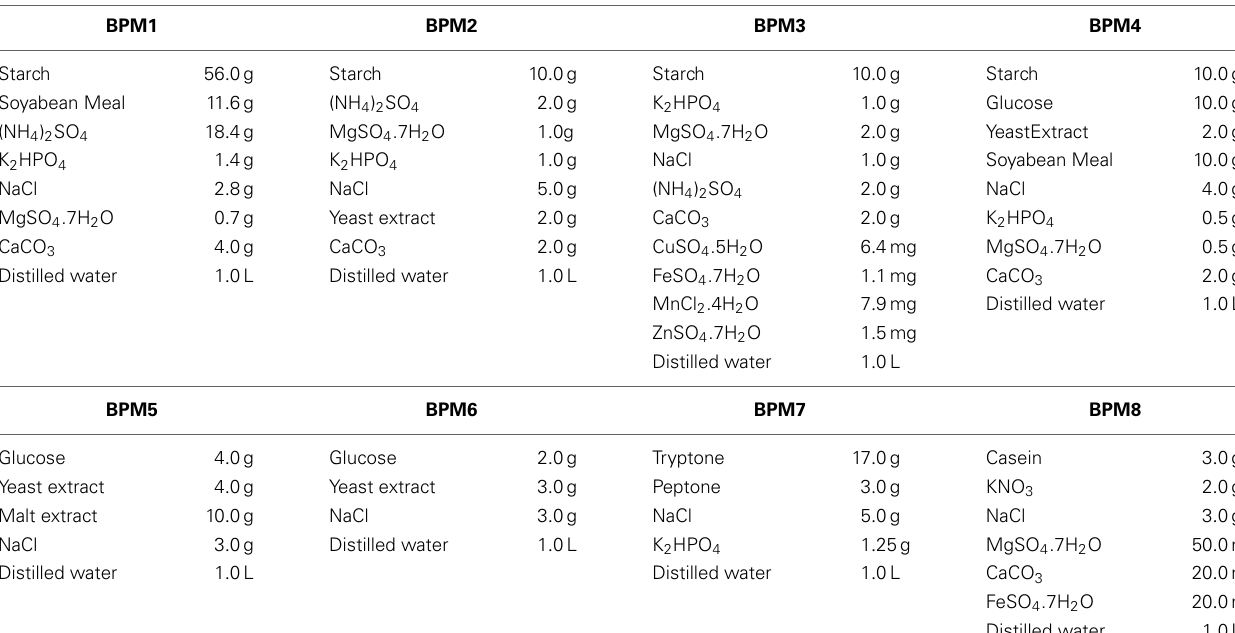
Table 1 | Composition of eight different media used for selection of a basal medium for JAJ13. BPM1 BPM2 BPM3 BPM4 Starch 56 . 0g